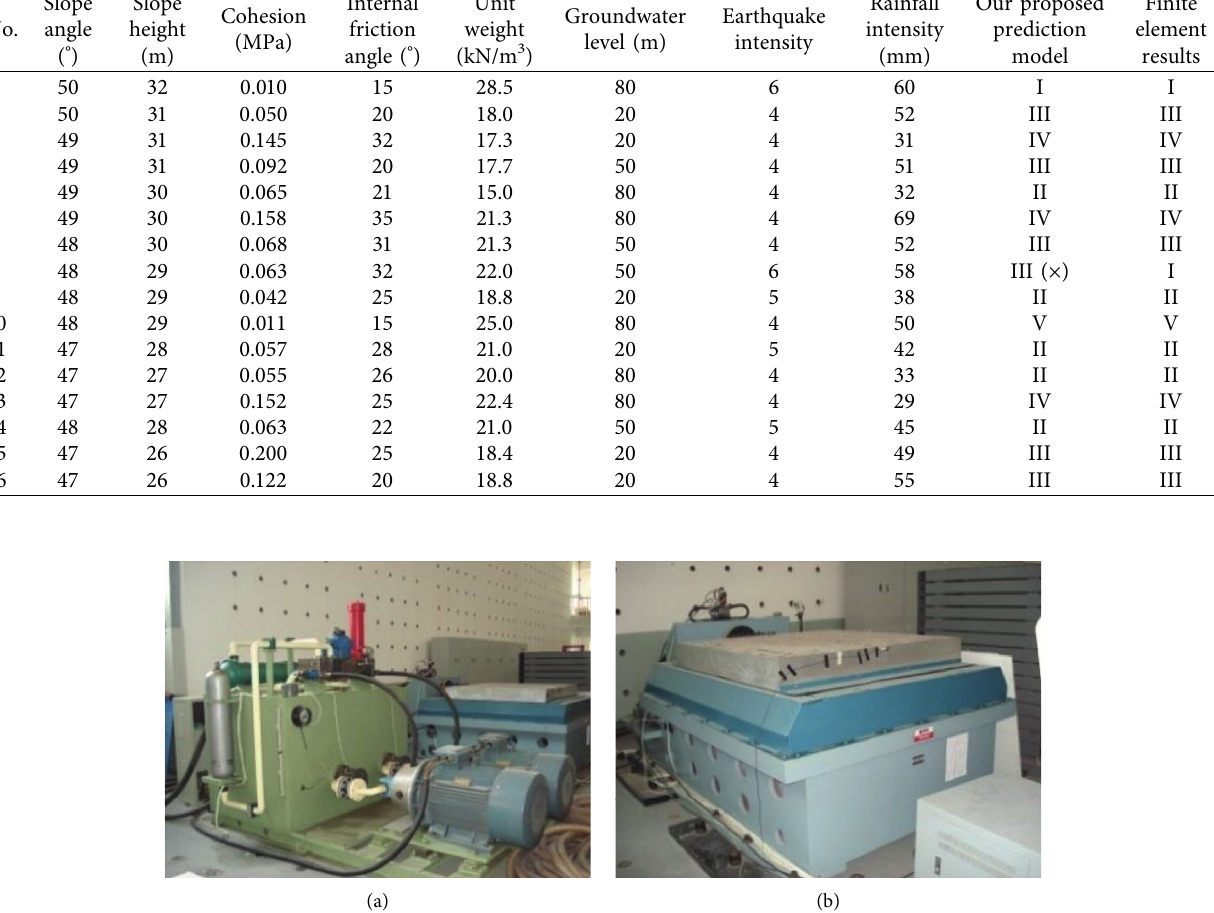
Figure 8: Shaking table test equipment. (a) Hydraulic system. (b) Shaking table.